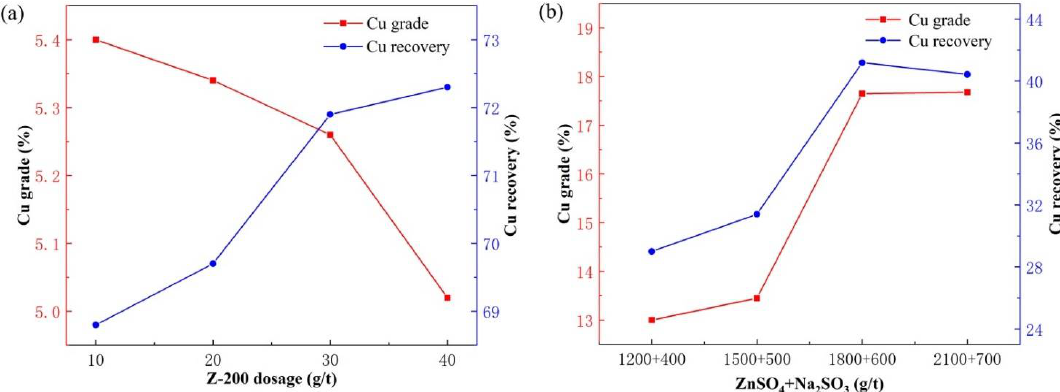
Figure 4. Experimental flow charts for the effects of Z-200 ( a ) and ZnSO 4 + Na 2 SO 3 ( b ) dosages on copper flotation.